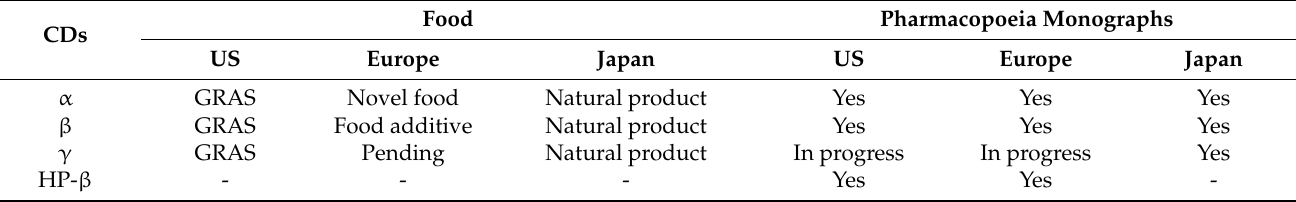
Table 7. Summary of existing